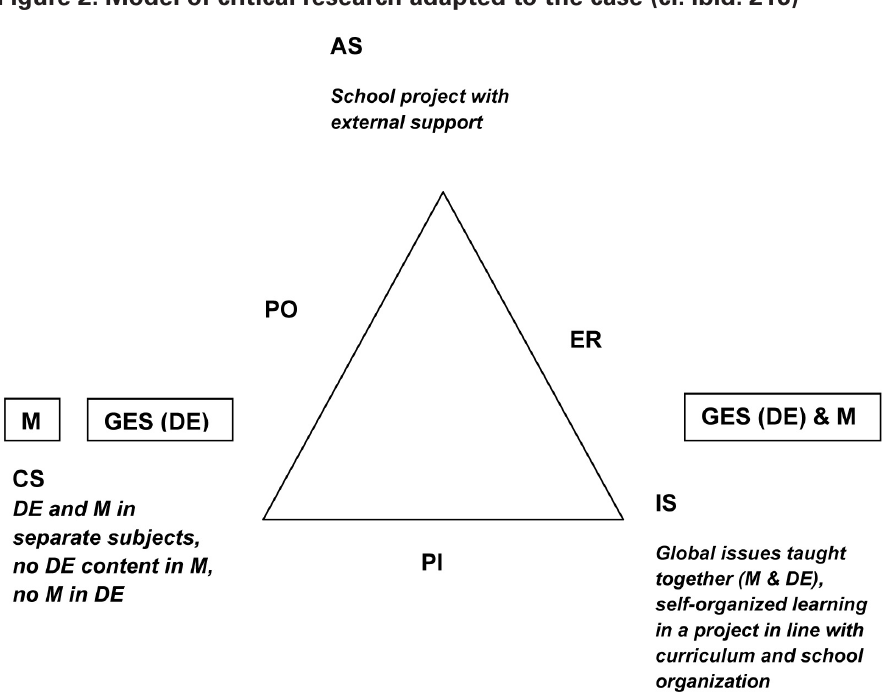
Figure 2: Model of critical research adapted to the case (cf. ibid: